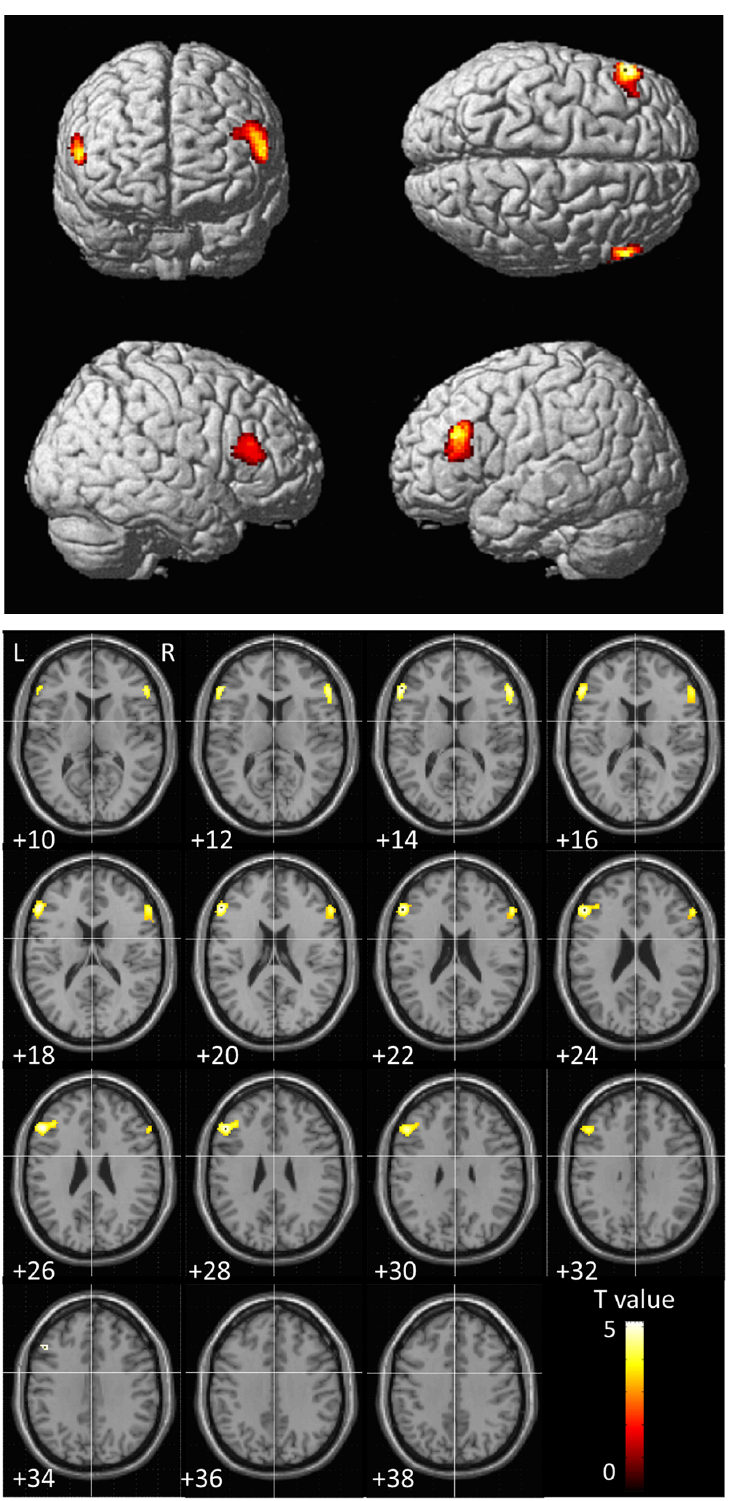
Fig 1. Voxel based morphometry results. Locations displaying significant differences between AN and control participants in regional GMV. Significantly lower GM densities among AN participants were revealed in the bilateral IFG (Brodmann area 45/46). Color scale: 0 – 5 represents